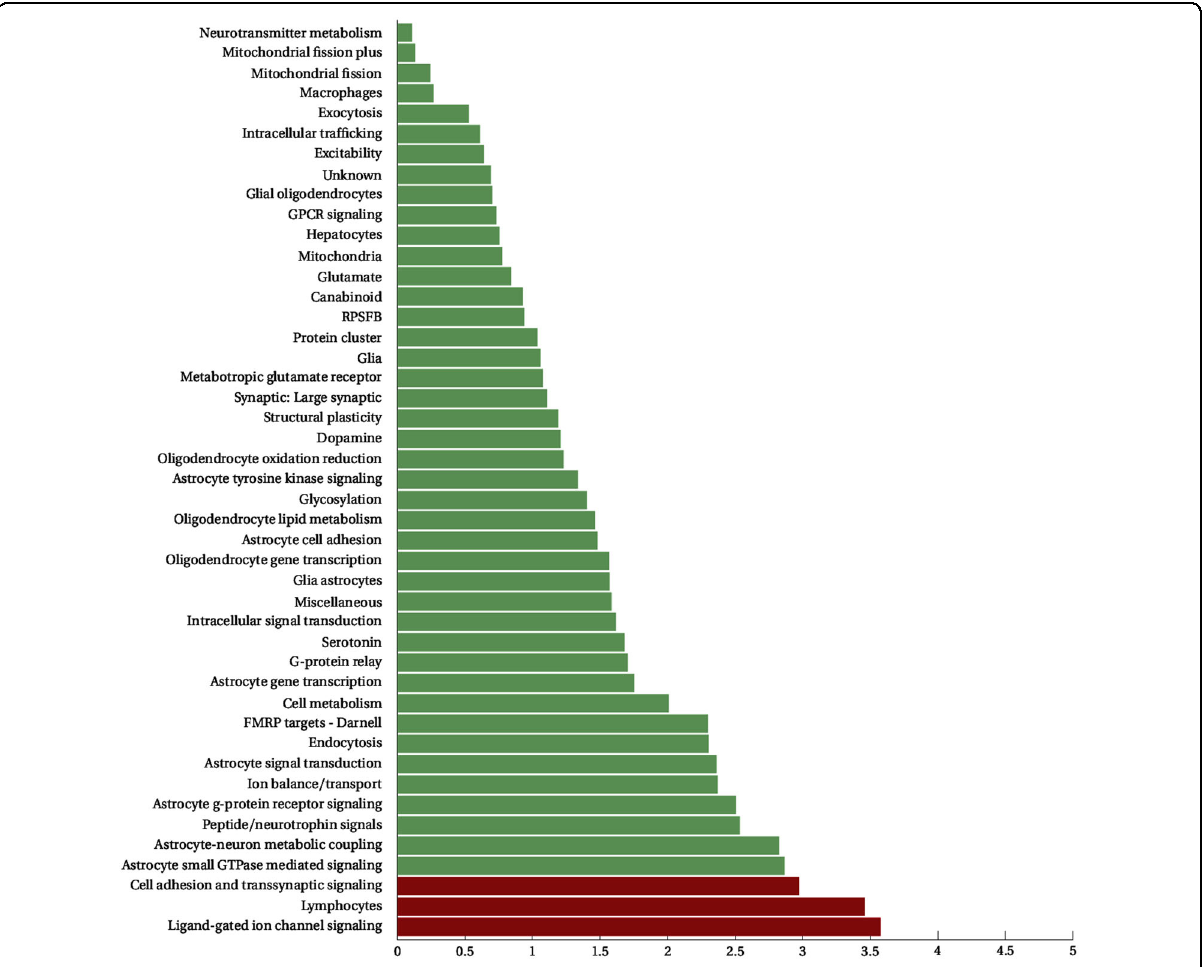
Fig. 2 Results of gene set analysis as implemented by SBA. The gene sets that crossed the signi fi cance threshold are depicted in